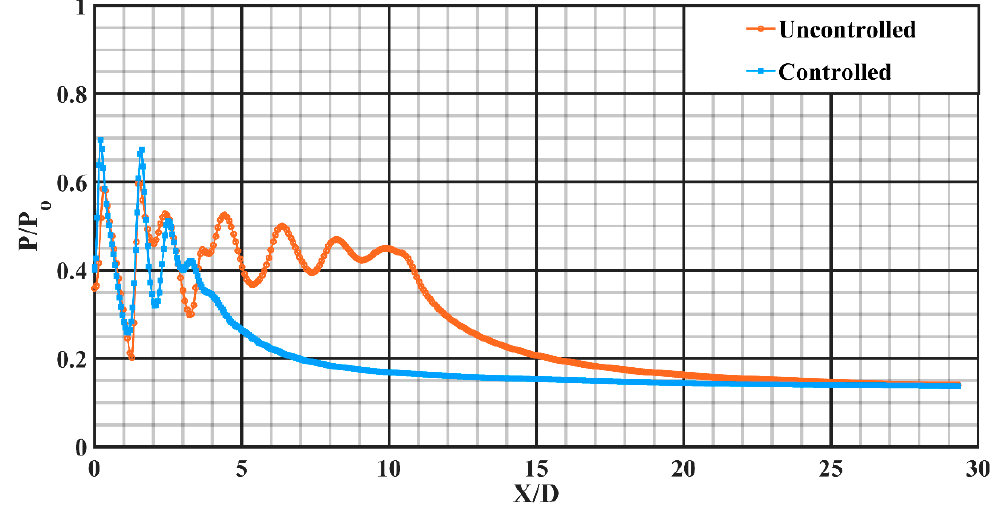
Figure 15. Decay of Jet centerline pressure for Mach 1.8 at NPR 8.